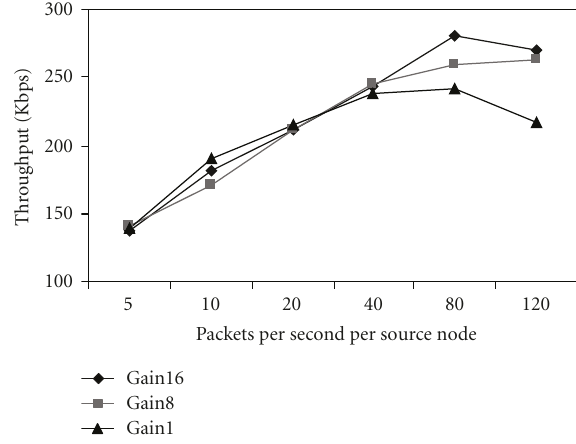
Figure 27: Throughput of OMNI IEEE 802.11 with di ff erent antenna